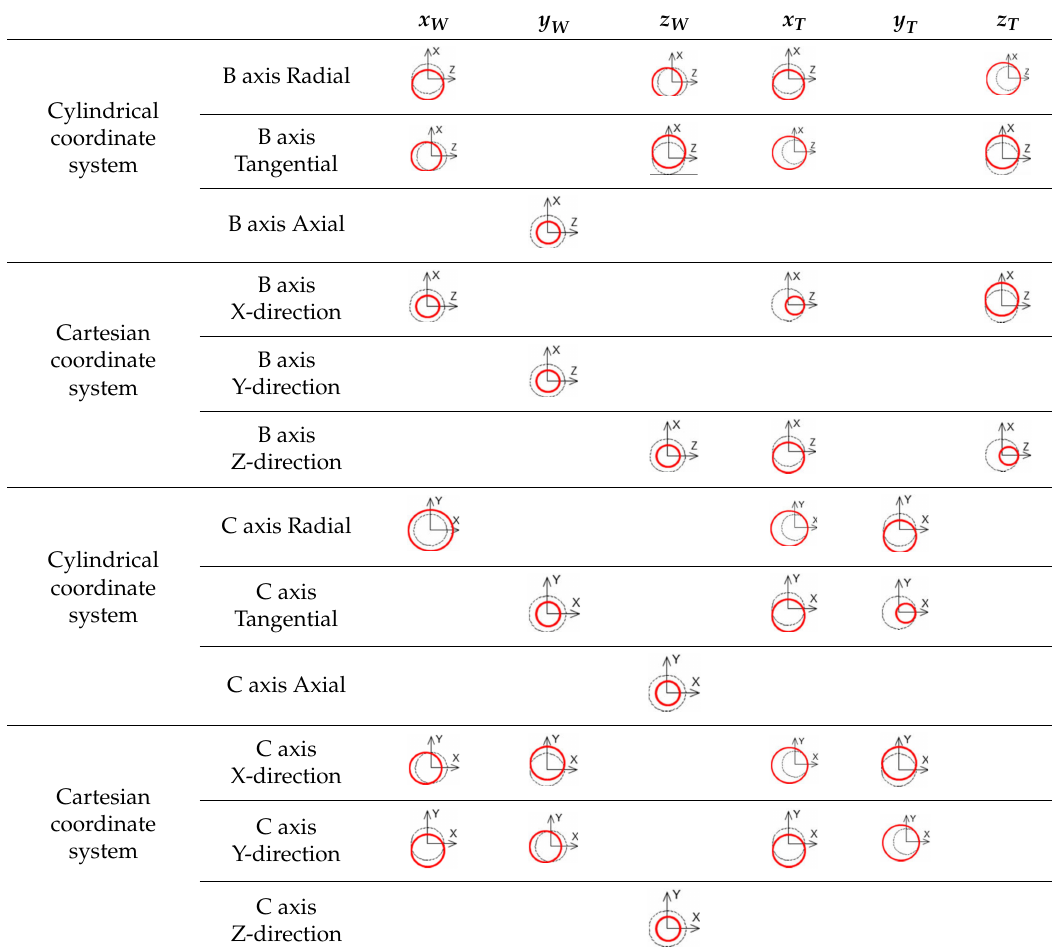
Table 4. Influence of mounting errors of ball bar on the eccentricity of circular